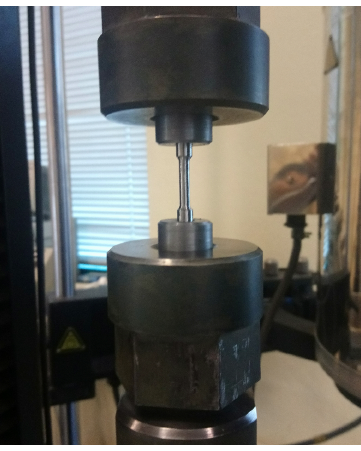
Figure 3: Manufactured cylindrical sample mounted in tensile test stand